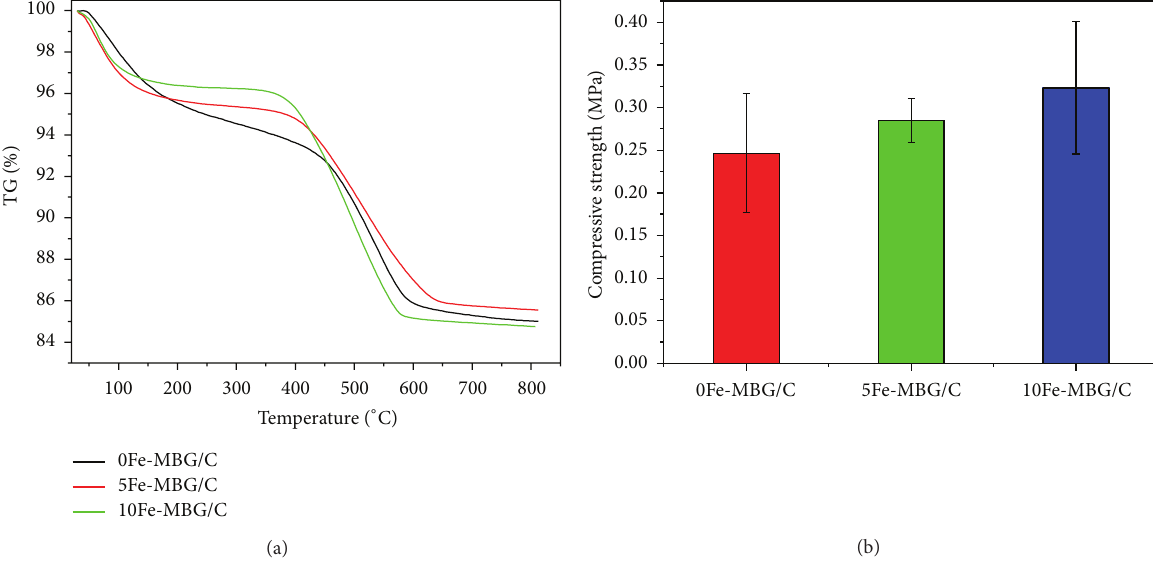
the compressive strengths of the 0Fe-MBG/C,